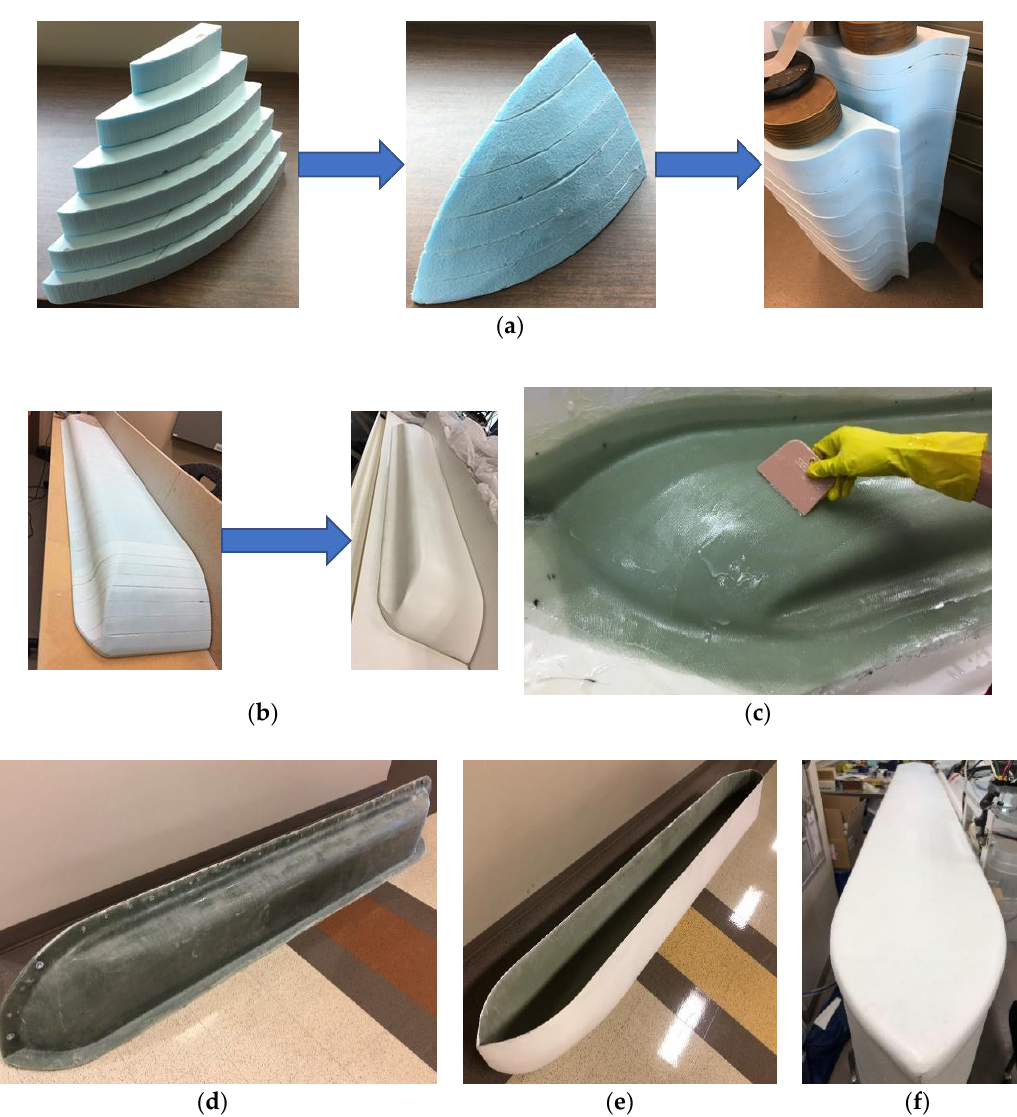
Figure 6. Fabrication of fiberglass pontoons: ( a ) cutting, sanding, and bonding polystyrene plug sections; ( b ) epoxy coating, sanding, and gel-coating of plug; ( c ) fiberglass lay-up of mold over polystyrene plug; ( d ) assembly of mold halves (shown with keel upward); ( e ) fiberglass pontoon after lay-up inside mold and application of multiple finish coats; and ( f ) separately cast pontoon cap installed.